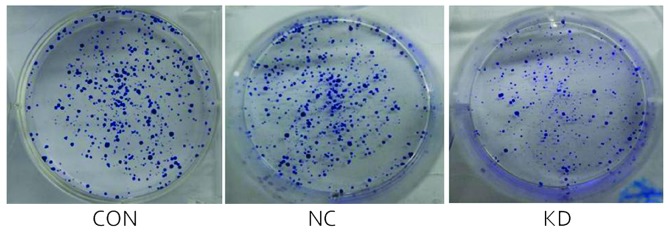
Result of colony forming experiments. CON, control; NC, negative control; KD, interference group.